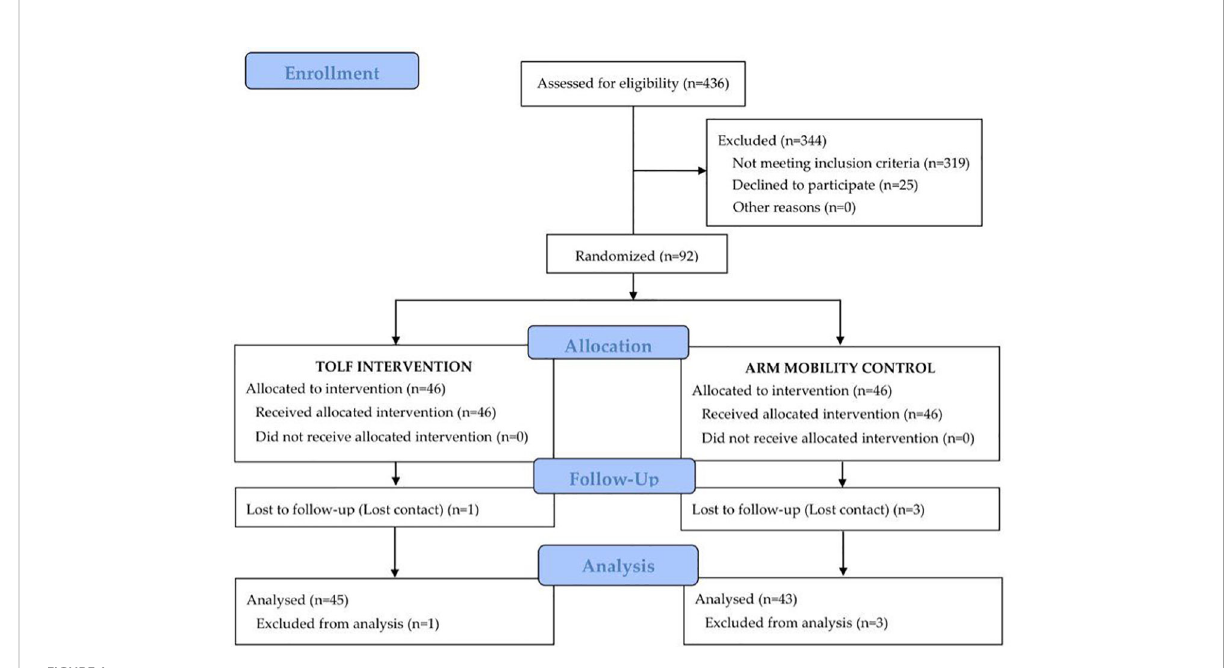
FIGURE 1 Participant fl ow